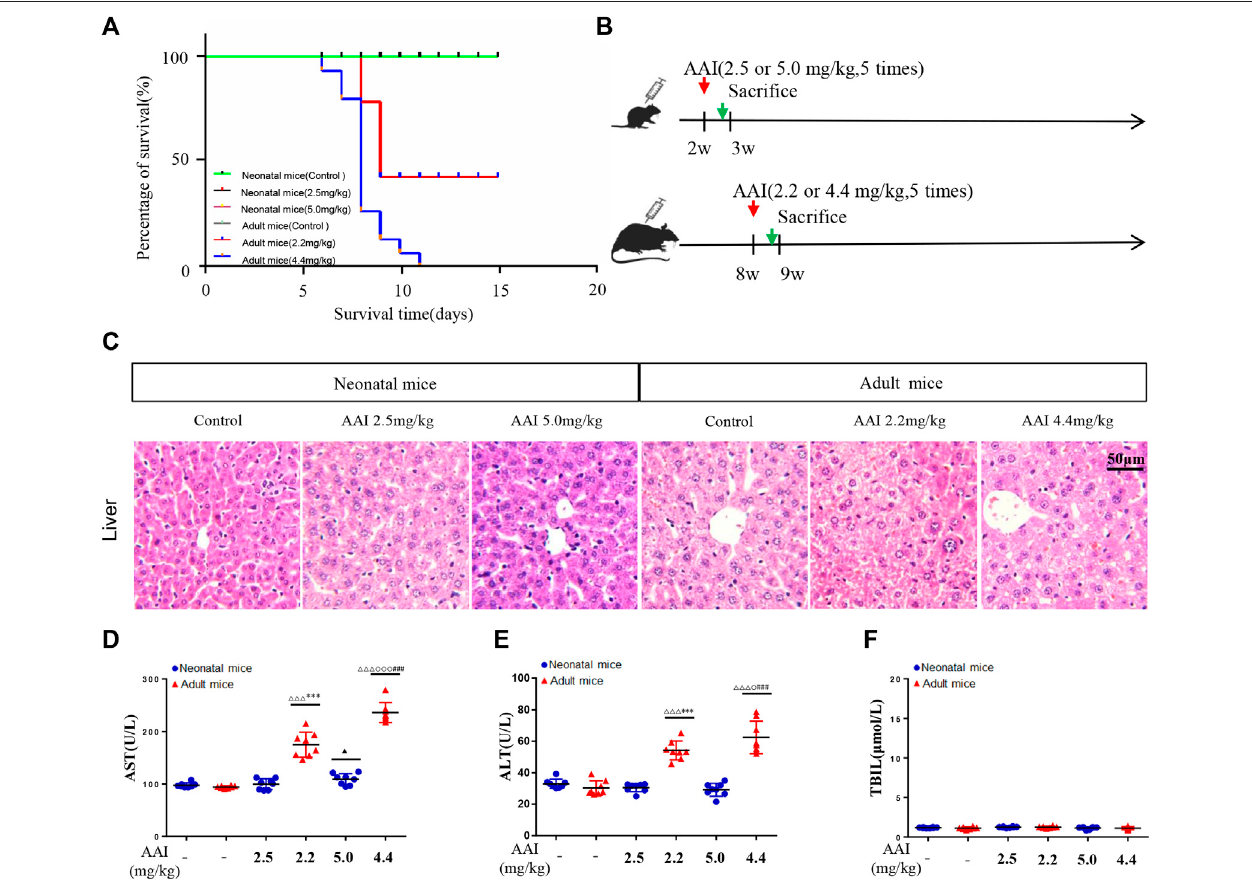
FIGURE 1 | AAI induced indistinct liver injury in neonatal mice compared to adult mice based on a short-term observation study. (A) Survival curve of the animals subjected to AAI. (B) Schematic diagram of the study design. AAI was administered by intraperitoneal injection (once a day from Monday to Friday for a total of 5 days). (C) Representativemicroscopyimagesofhematoxylinandeosin-stainedlivers(scalebars,50 μ m).ClinicalbiochemicalparametersbetweenthecontrolandAAI-treated groups: (D) aspartate aminotransferase; (E) alanine aminotransferase; (F) total bilirubin; Data are shown as the mean ± SD. Asterisks above a group between (cid:129) (cid:129) groups indicate a signi fi cant differences: ▲▲▲ p < 0.001, ▲▲ p < 0.01, ▲ p < 0.05 vs. neonatal mice control group; △△△ p < 0.001, △△ p < 0.01, △ p < 0.05 (cid:129)(cid:129)(cid:129) (cid:129)(cid:129) (cid:129) (cid:129) (cid:129) mice control group; p < 0.001, p < 0.01, p < 0.05 vs. neonatal mice low-dose group; ○○○ p < 0.001, ○○ p < 0.01, ○ p < 0.05 (cid:129) (cid:129) *** p < 0.001, ** p < 0.01, * p < 0.05 neonatal vs. adult mice low-dose group; ### p < 0.001, ## p < 0.01, # p < 0.05 neonatal